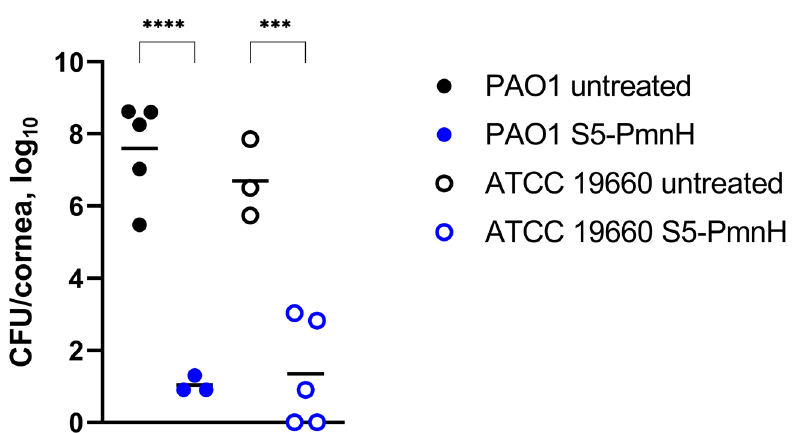
Figure 4. CFU counts in ex vivo porcine corneas, infected with P. aeruginosa ATCC 19660 or PAO1 and treated with S5-PmnH. 3 × 10 4 CFU of P. aeruginosa ATCC 19660 strain or 0.4 × 10 4 CFU of P. aeruginosa PAO1 strain were applied to cornea and incubated for 16–20 h at 37 °C. Then 5 µg of S5-PmnH were applied to cornea and incubated for additional 16–20 h. Statistical significances of the quantitative data were analyzed using GraphPad Prism software by the 1-way repeated measures ANOVA and Bonferroni’s’ correction for multiple comparisons. Mean is indicated by horizontal bar. ***P ≤ 0.001, ****P ≤ 0.0001 vs vehicle-treated